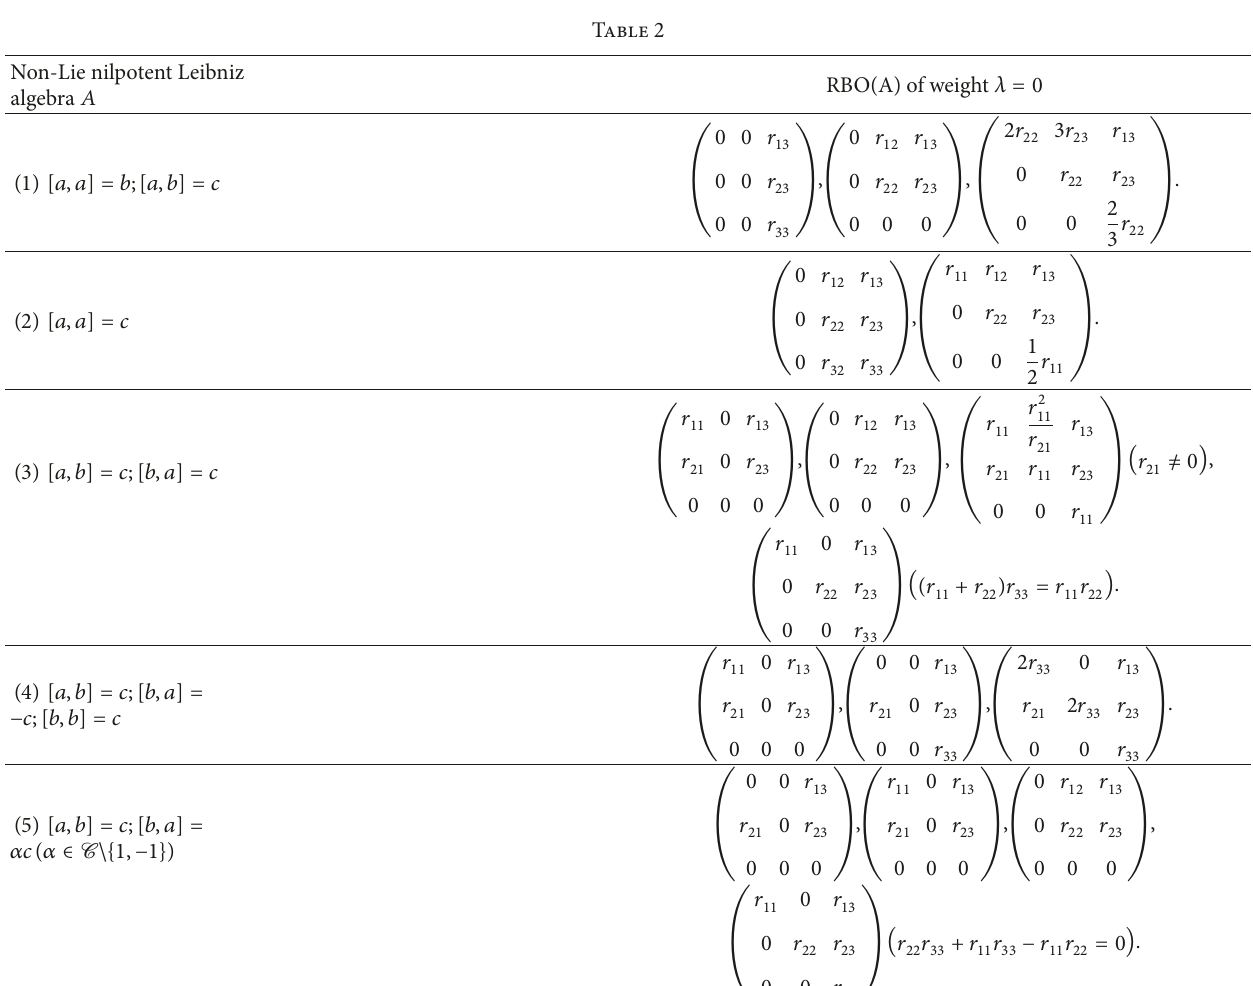
RBO(A) of weight 𝜆 =